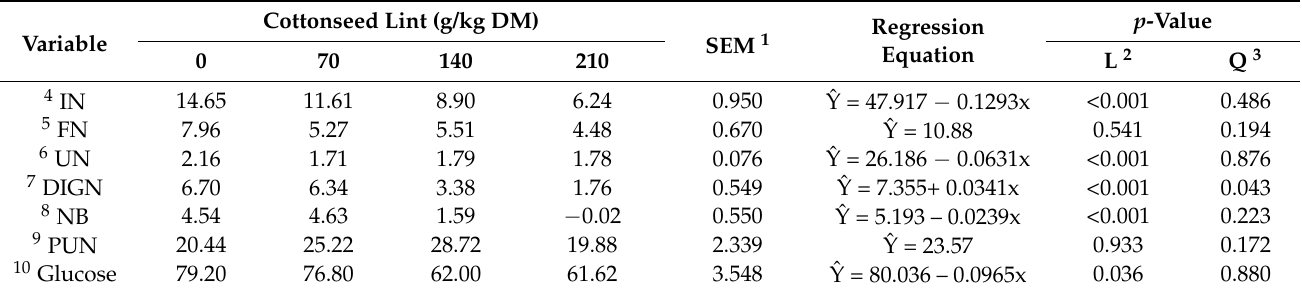
Table 7. Average values of values of the nitrogen fractions in urine, feces, and plasma for diets containing cottonseed lint